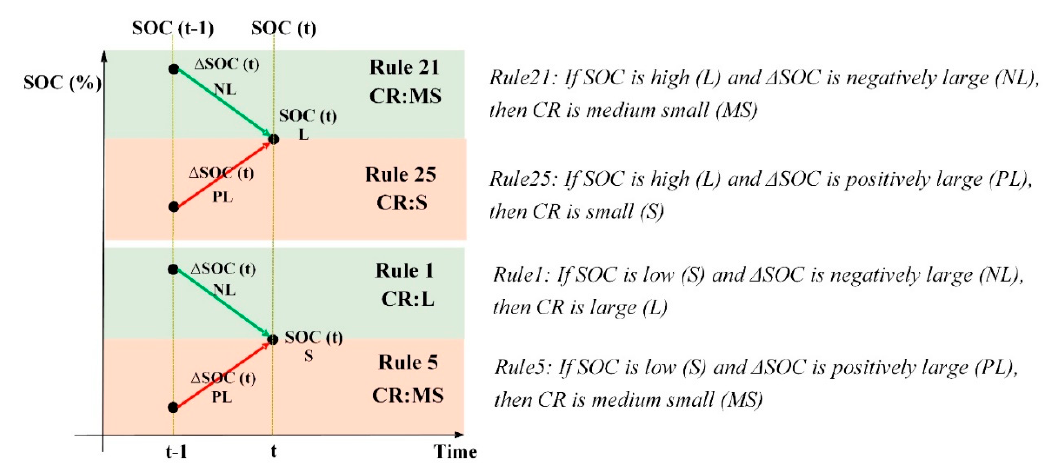
Figure 6. Illustration of charging behavior from rule table.